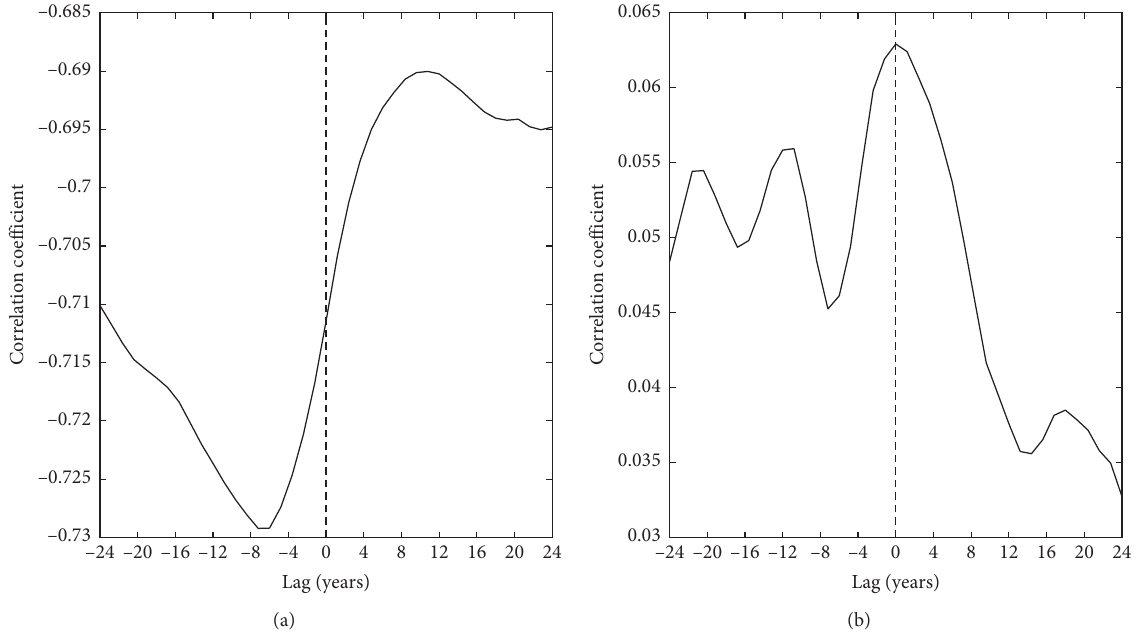
Figure 3: Cross-correlation coefficients of daily SSN-CRI and SSN-SWS for the two Solar Cycles 23 and 24 combined. The abscissa designates the time delay with respect to the daily sunspot numbers. (a) SSN-CRI. (b) SSN-SWS.